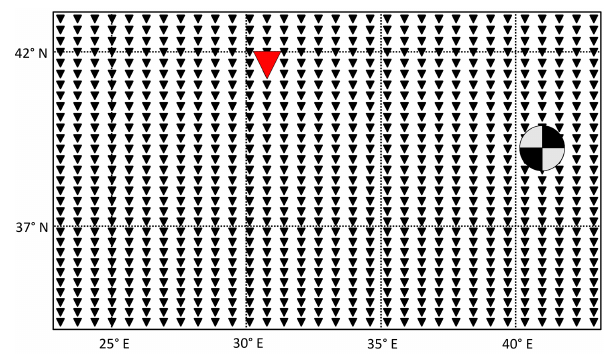
Figure 1. The grid of receivers (black triangles) on the surface of the computational domain. The source is located at 5km depth; its location and orientation are indicated by the beach-ball plot. The receiver marked by a large red triangle and at an epicentral distance of 910km is used for the examples presented in Sects. 3.1 and